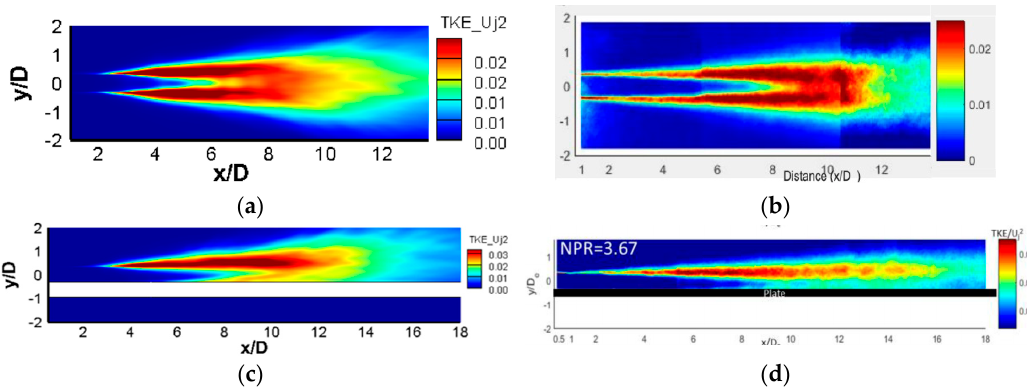
Figure 27. Turbulent kinetic energy normalized by jet velocity squared. ( a ) Baseline, Numerical (NPR = 3.67, TR = 3.0), ( b ) Baseline, Experiment (NPR = 3.67, TR = 2.0) (Ref. [88]). ( c ) With Plate, Numerical (NPR = 3.67, TR = 3.0), ( d ) With Plate, Experiment (NPR = 3.67, TR = 2.4) (Ref. [87]).